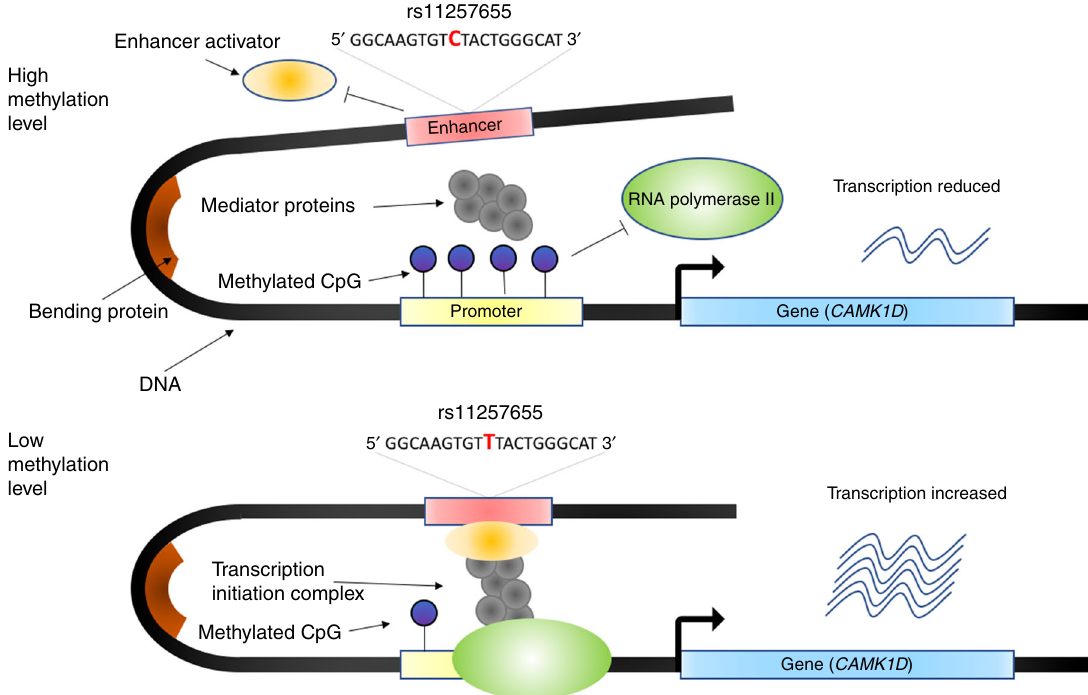
Fig. 3 Hypothesized regulatory mechanism at the CAMK1D locus for T2D. When the allele of rs11257655 in the enhancer region (red) changes from C to T, the enhancer activator protein FOXA1 / FOXA2 (orange ellipsoid) binds to the enhancer region and the DNA methylation level in the promoter region is reduced; this increases the binding ef fi ciency of RNA polymerase II recruited by mediator proteins (gray circles) and, therefore increases the transcription of